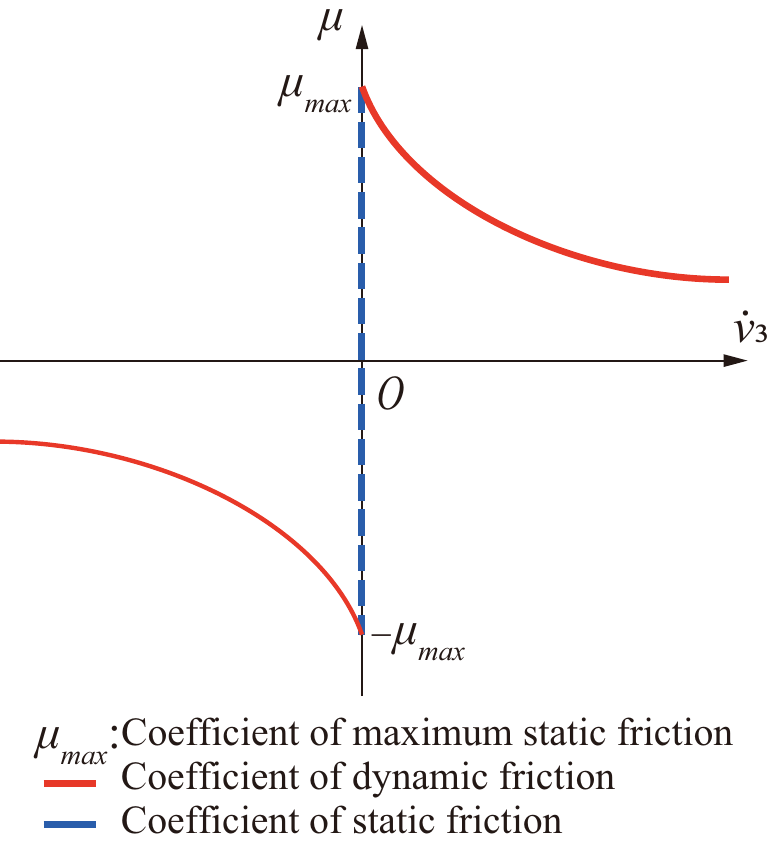
Figure 4. Relationship between coefficient of friction and relative velocity of wiper blade and wiping